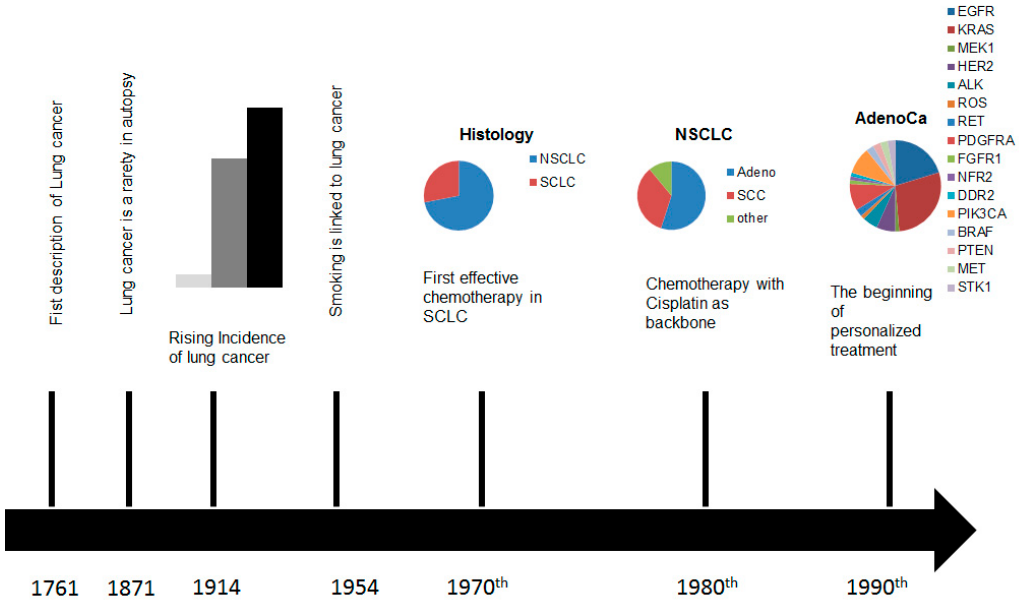
Figure 1. Time scale of the developments in the diagnostics and treatment of lung cancer.